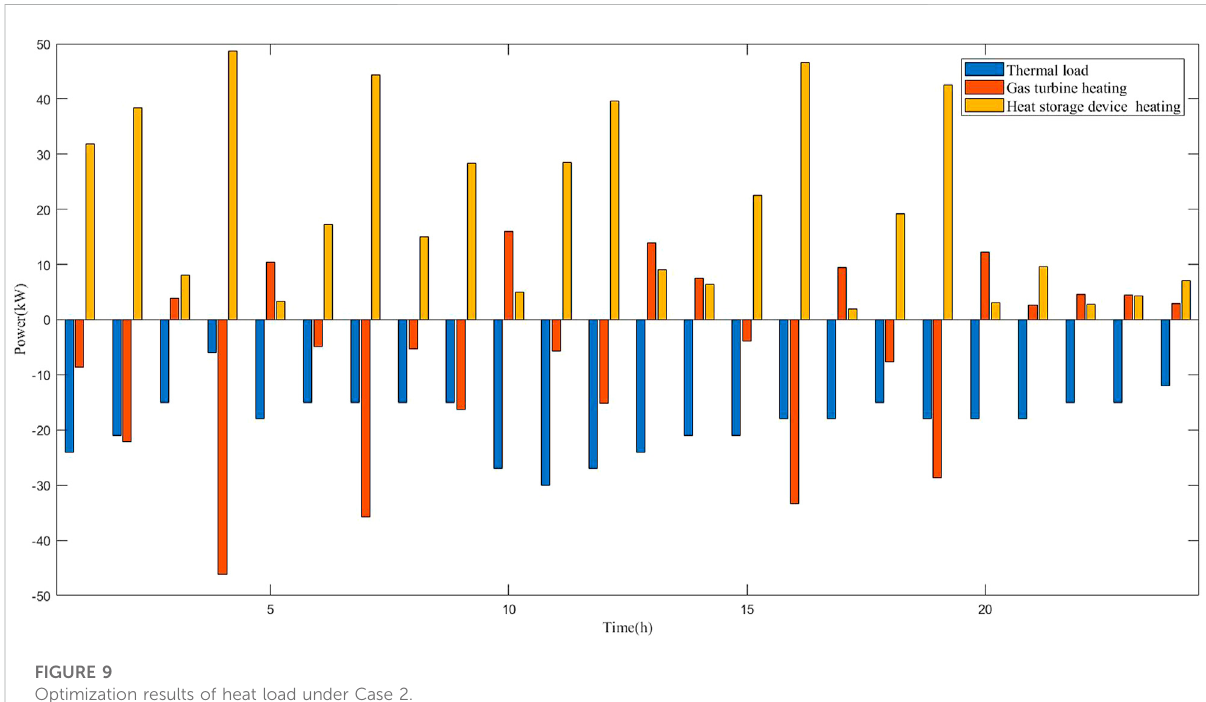
FIGURE 9 Optimization results of heat load under Case 2.